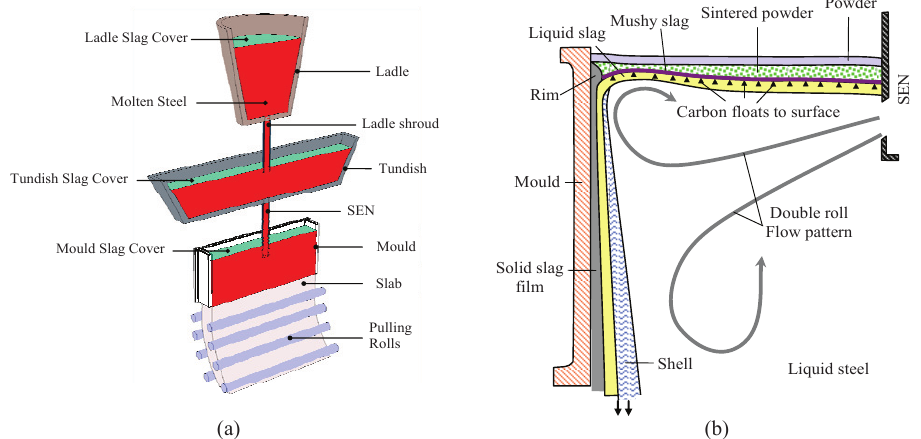
Figure 1. Schematic diagram showing (a) continuous casting process and (b) various phases formed in the mould.